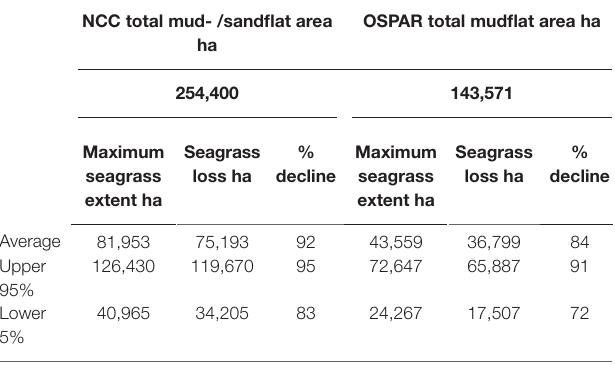
Average and 95% confidence interval